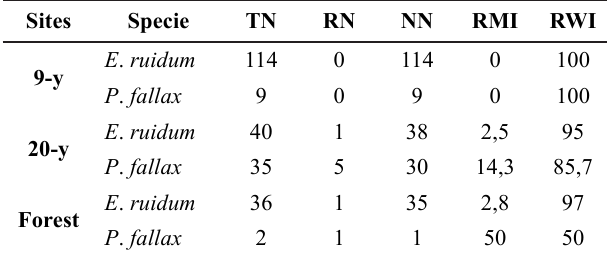
Table 3 . Temporal permanence of E. r uidum y P. fallax nests in the study site. TN = Total nests presented in the first sampling; (RN) remaining nest in second sample 1, NN: new nests that appear in sample 2, RMI = Remaining index, RWI = Renewal index.